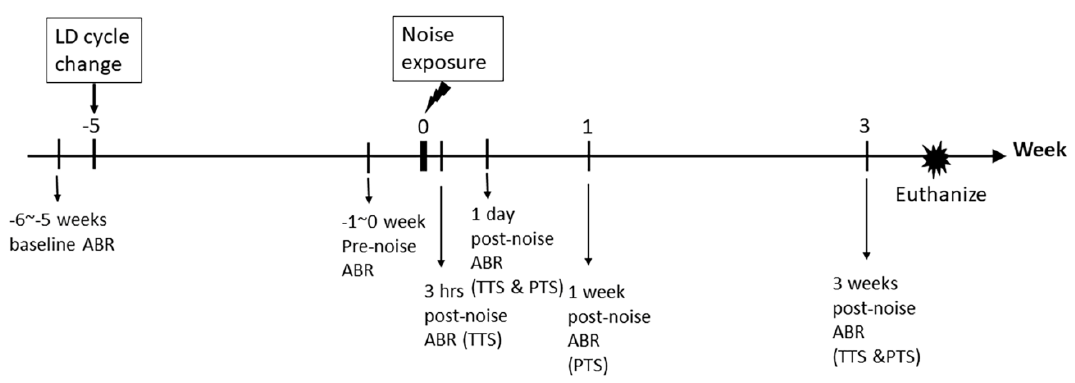
Figure 3. Timeline of experiments for testing the auditory brainstem response (ABR). The ABRs were tested before normal light–dark cycle change, and before noise exposure. Post-noise ABRs were tested at 3 h, 1 day, and 3 weeks after noise exposure in the TTS (temporary threshold shift) experiments, and at 1 day, 1 week, and 3 weeks after noise exposure in the PTS (permanent threshold shift) experiments.